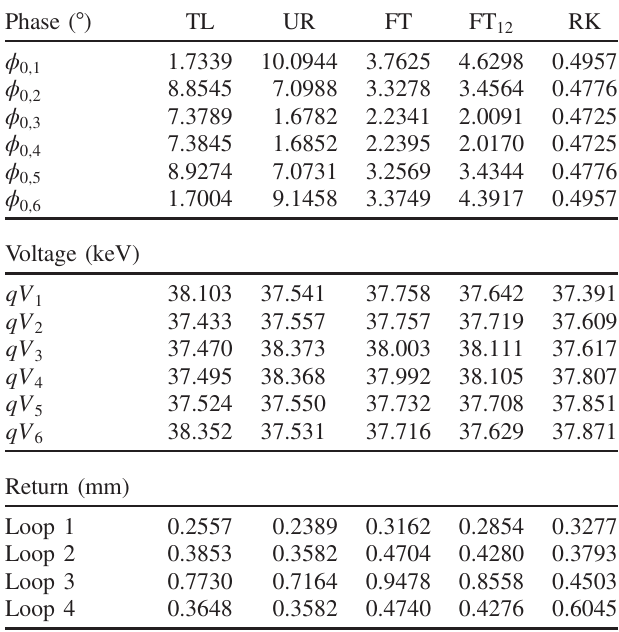
tolerance when only the indicated j parameter is imperfect. Ranges represent (cid:3) Δ j offsets from ideal settings, as calculated from Eq. (30). Injected particle energy is 6 MeV in all cases except the FT 12 column, which represents a FT model with an injector energy of 12 MeV instead of 6